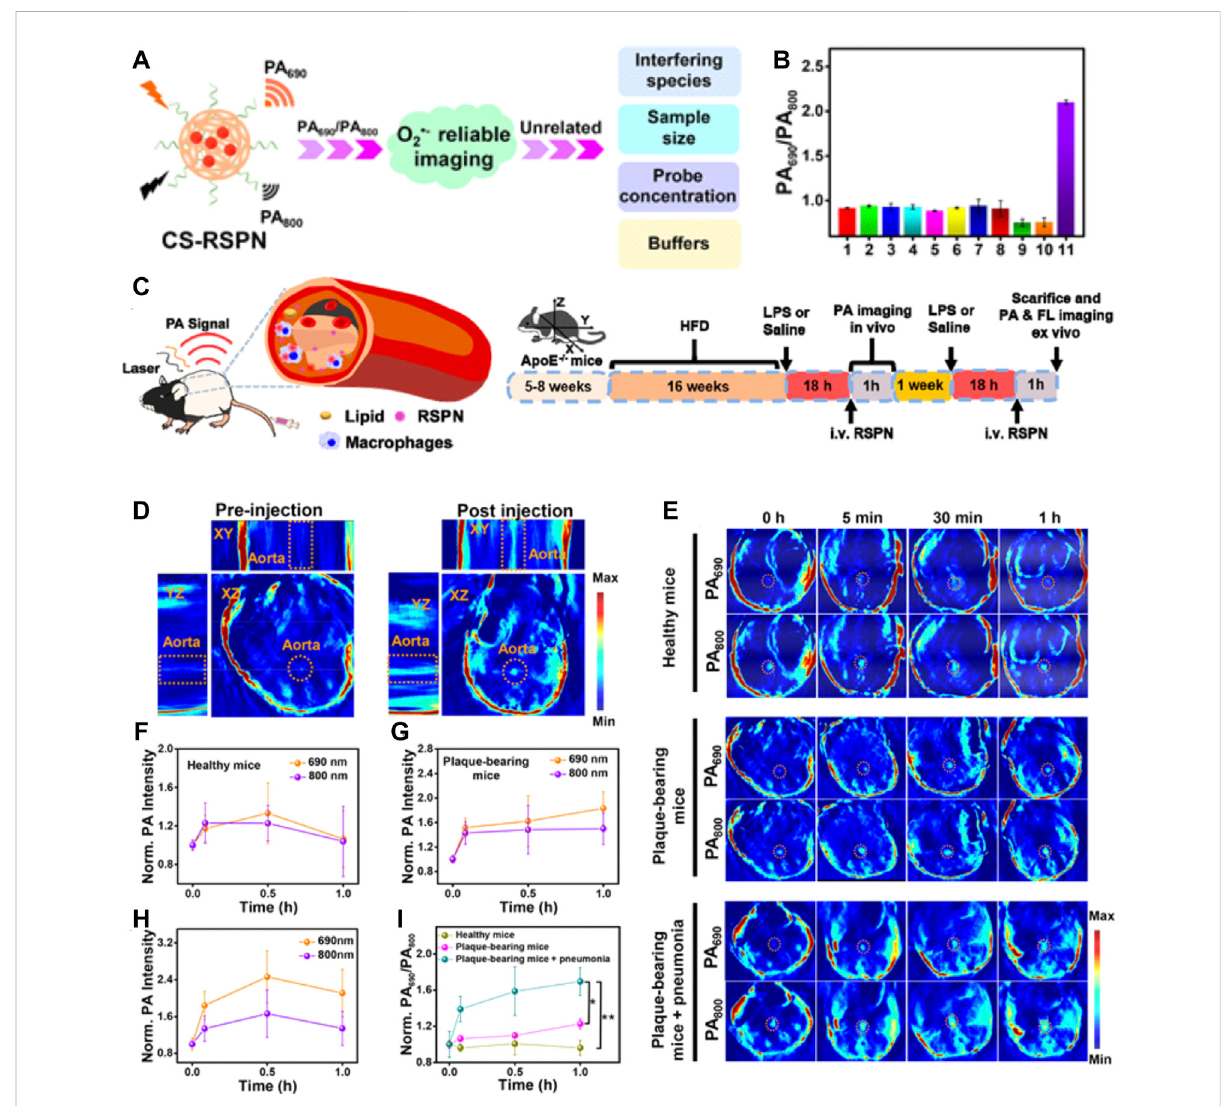
FIGURE 10 (A) Schematic illustration of CS-RSPN for reliable ratiometric photoacoustic imaging of O 2 − . (B) Selective response: PA690/PA800 ratios of RSPN. (C) Scheme of RSPN for photoacoustic imaging of atherosclerotic plaques and administration procedure ( n = 3). (D) 3D PA image of plaque- bearing mice before and after injection of RSPN. Excitation: 690 nm. Aorta regions are depicted by dotted circles. (E) PA images after injection of RSPN of healthy mice, plaque-bearing mice, and plaque-bearing mice complicated with pneumonia. Data are shown as mean ± SD ( n = 3). Aorta regions are depicted by dotted circles. (F – I) Normalized PA690 and PA800 of healthy mice, plaque-bearing mice, and plaque-bearing mice complicated with pneumonia (two-tailed Student ’ s t test, * p < 0.05, ** p < 0.01). (Copyright permission from the American Chemical Society) (Ma et al.,